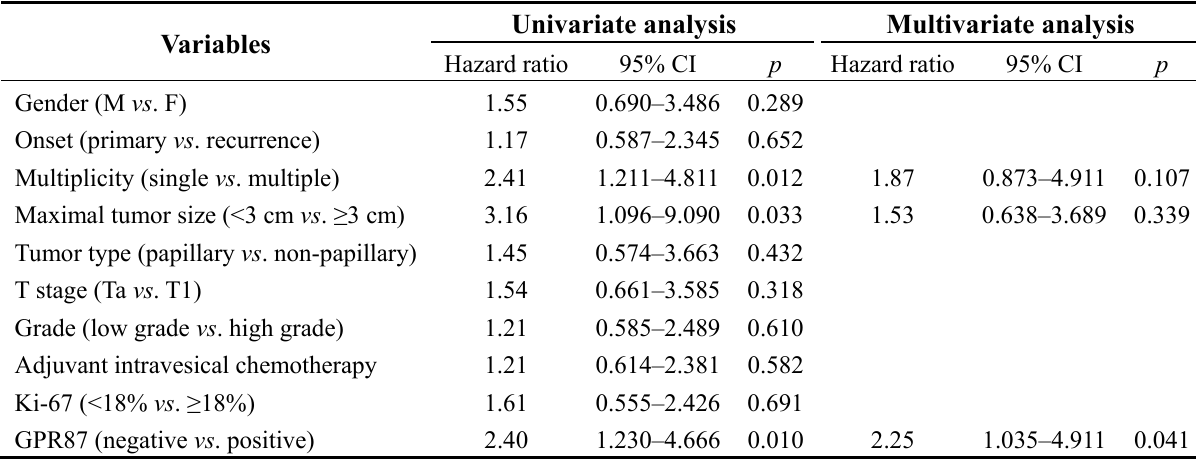
Table 1. Univariate and multivariate analyses of factors associated with intravesical recurrence-free